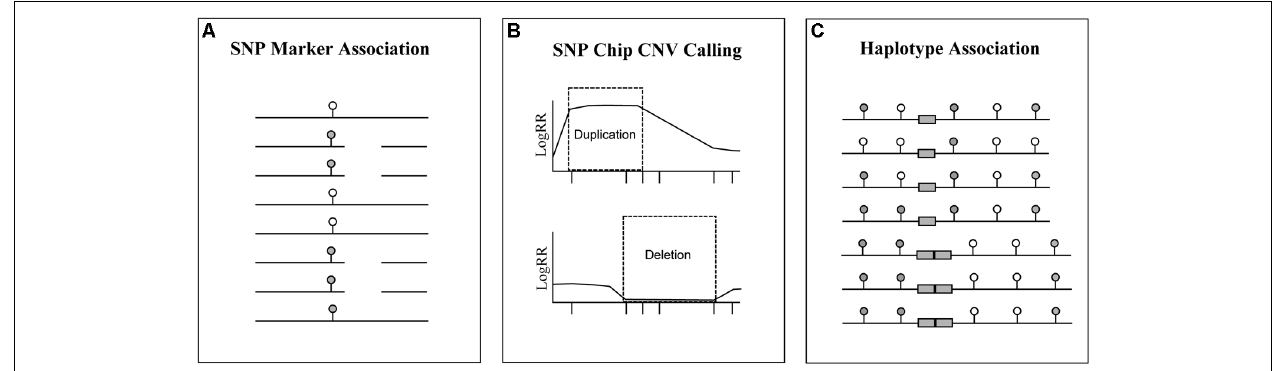
for tracking SVs using SNP genotyping arrays: (A) association of SNP marker genotypes (filled and empty ovals) with the SV; (B) identification of SVs from the logR ratio (LogRR) intensity of SNP probes (X axis tick marks); (C) and association of SVs (duplicated gray boxes) with SNP markers that form